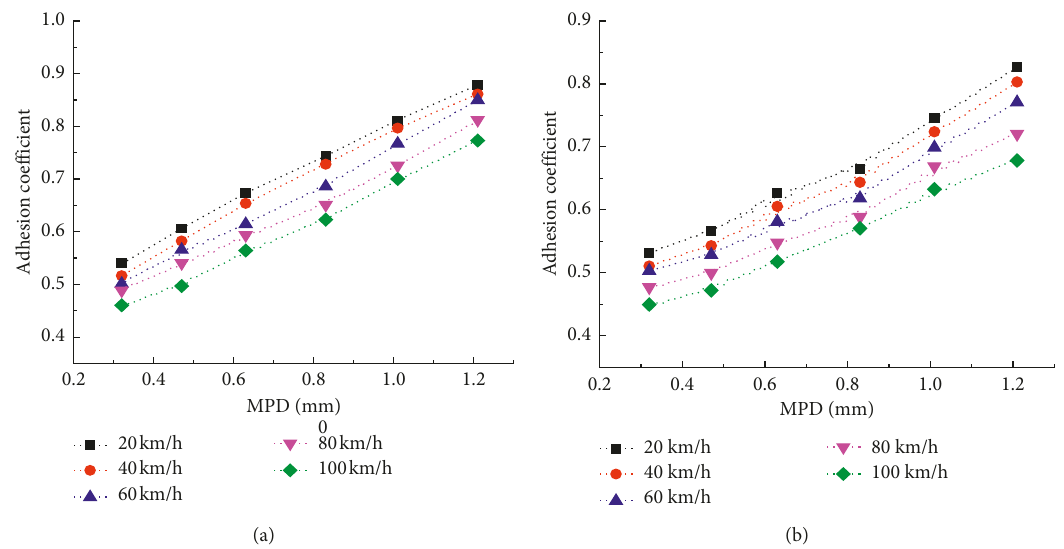
Figure 11: Variation of the adhesion coefficient with the MPD value: (a) 2mm of water film thickness; (b) 5mm of water film